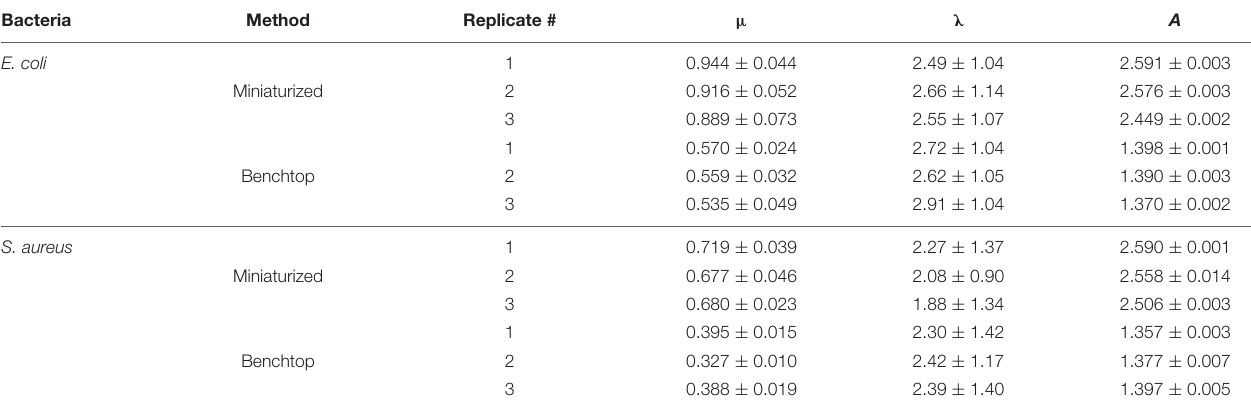
TABLE 2 | Parameters of the growth curves of Escherichia coli and Staphylococcus aureus obtained using the miniaturized setup and a benchtop UV-Vis spectrophotometer.